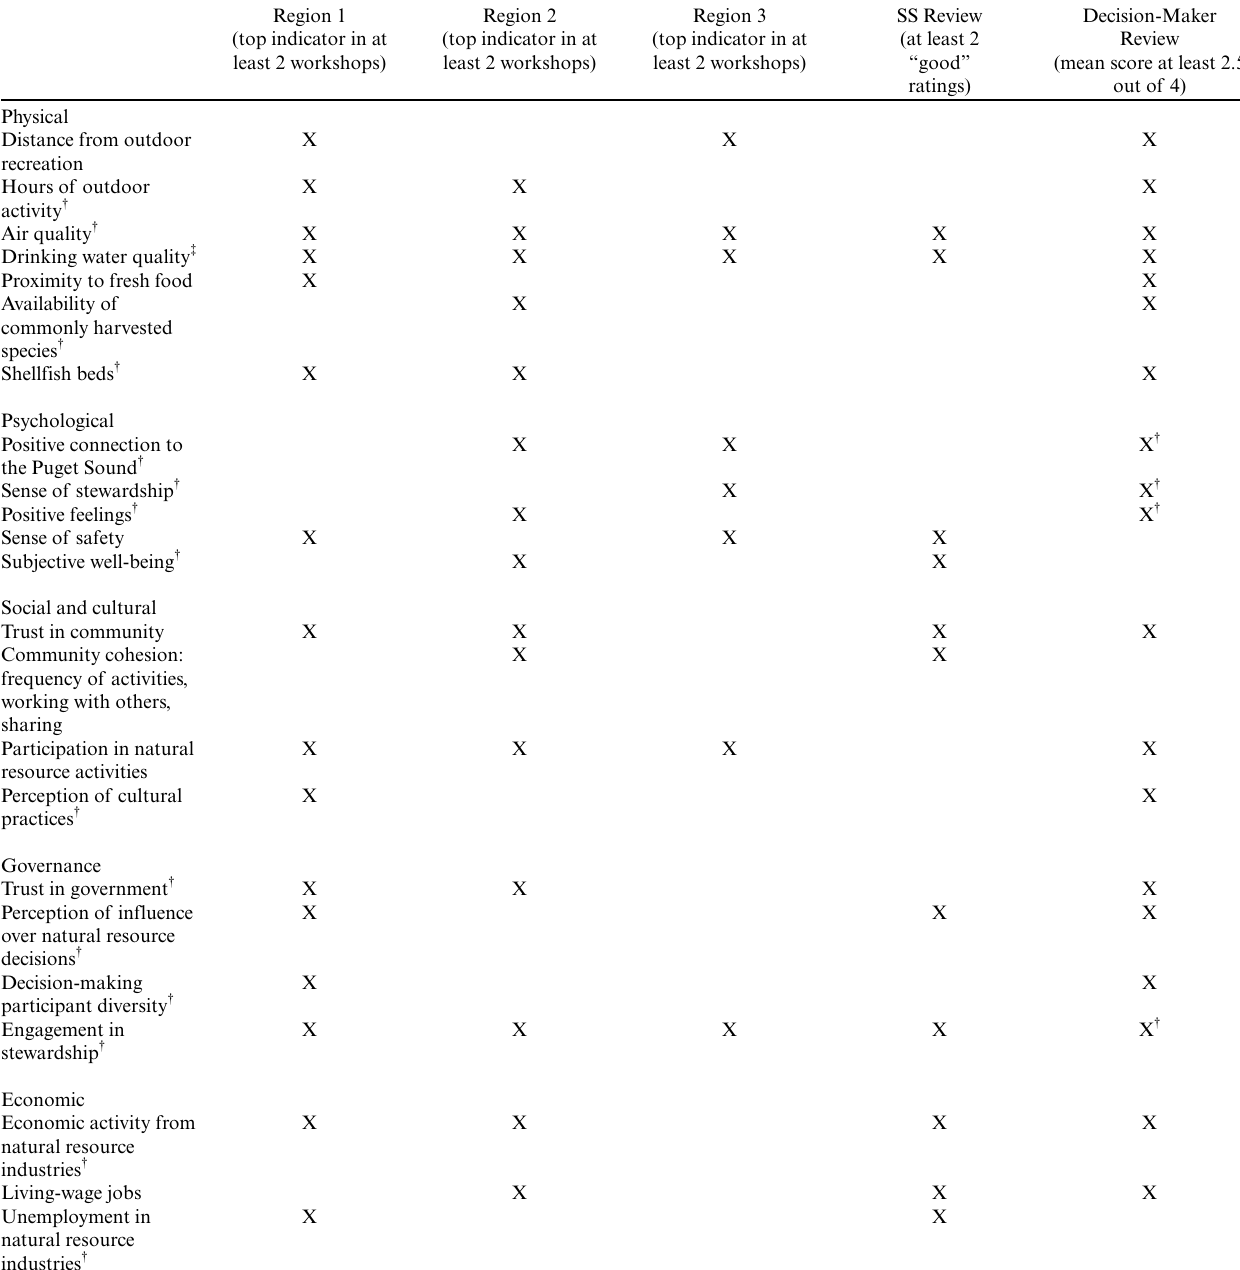
Table 2 . Prioritization of human well-being indicators across 3 stakeholder regions, social science (SS) reviewers, and decision makers. Indicators were marked for the regions when at least 2 workshop groups prioritized the indicator in the top 10 indicators. For the SS review, at least 2 out of 3 reviewers provided a “good” rating. For the decision makers, the indicator received a mean score of at least 2.5, the equivalent to a score of high or very